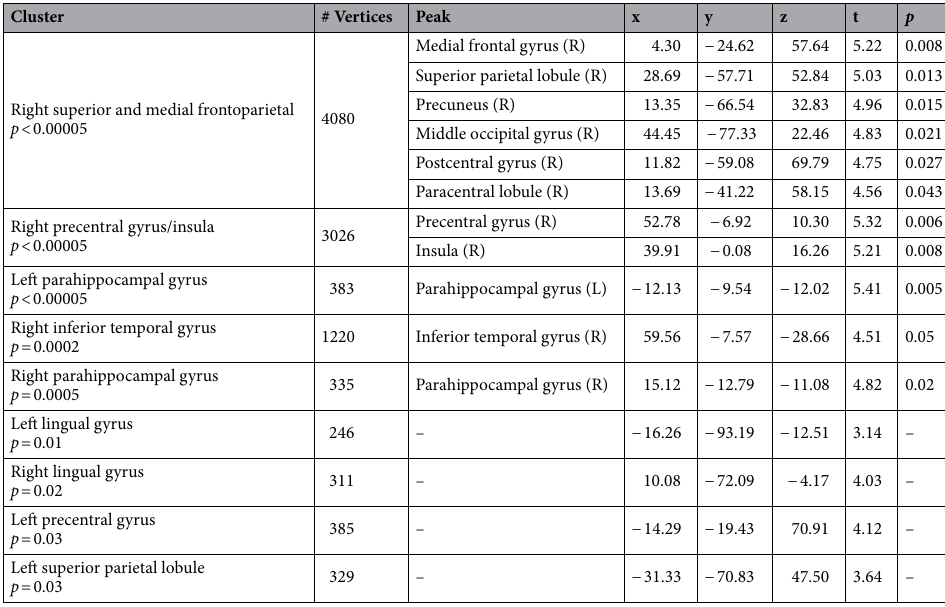
Table 5. Regions where cortical thickness was predicted by lesion load in placebo non-responders. Significance thresholds for vertices and clusters of contiguous vertices and are determined using Random Field Theory; corrected p -values are given. Due to some of the clusters being extensive, the coordinates (in MNI space) are given for either peak vertices for clusters featuring such peaks (labeled in hot colors on Fig. 3). For smaller clusters without peaks, average cluster coordinates are